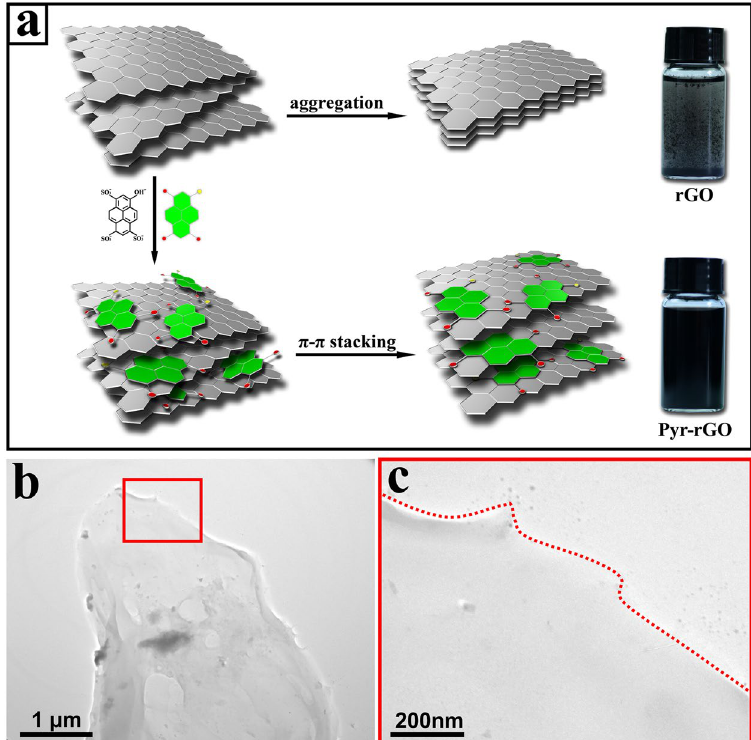
Figure 1. ( a ) The schematic of the aggregation by stacked rGO sheets and the supramolecular assembly of Pyr- rGO sheets with corresponding physical images in dispersion. ( b ) Low- and ( c ) high-magnification TEM image of the ultrathin Pyr-rGO